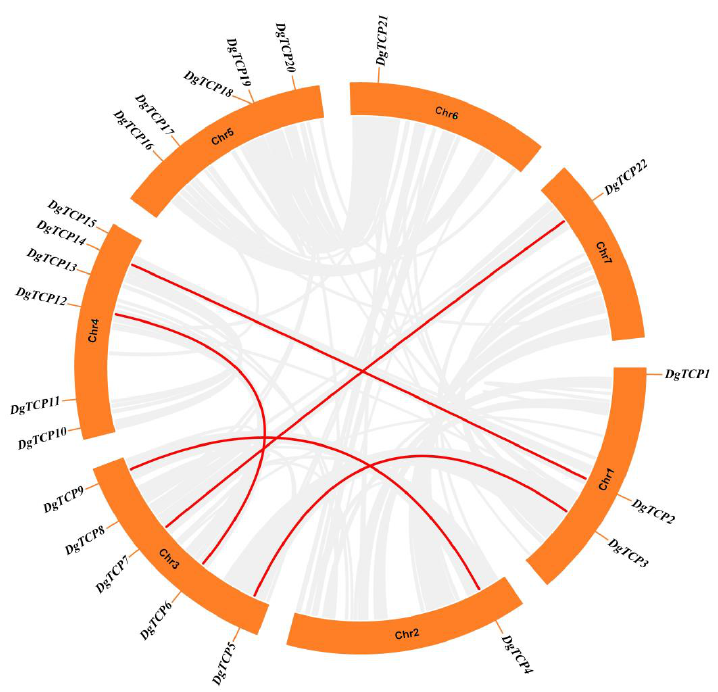
Figure 5. Genomic locations and segmental repeats of the DgTCP genes. The red lines represent five segmental duplicates of the 22 DgTCP genes.